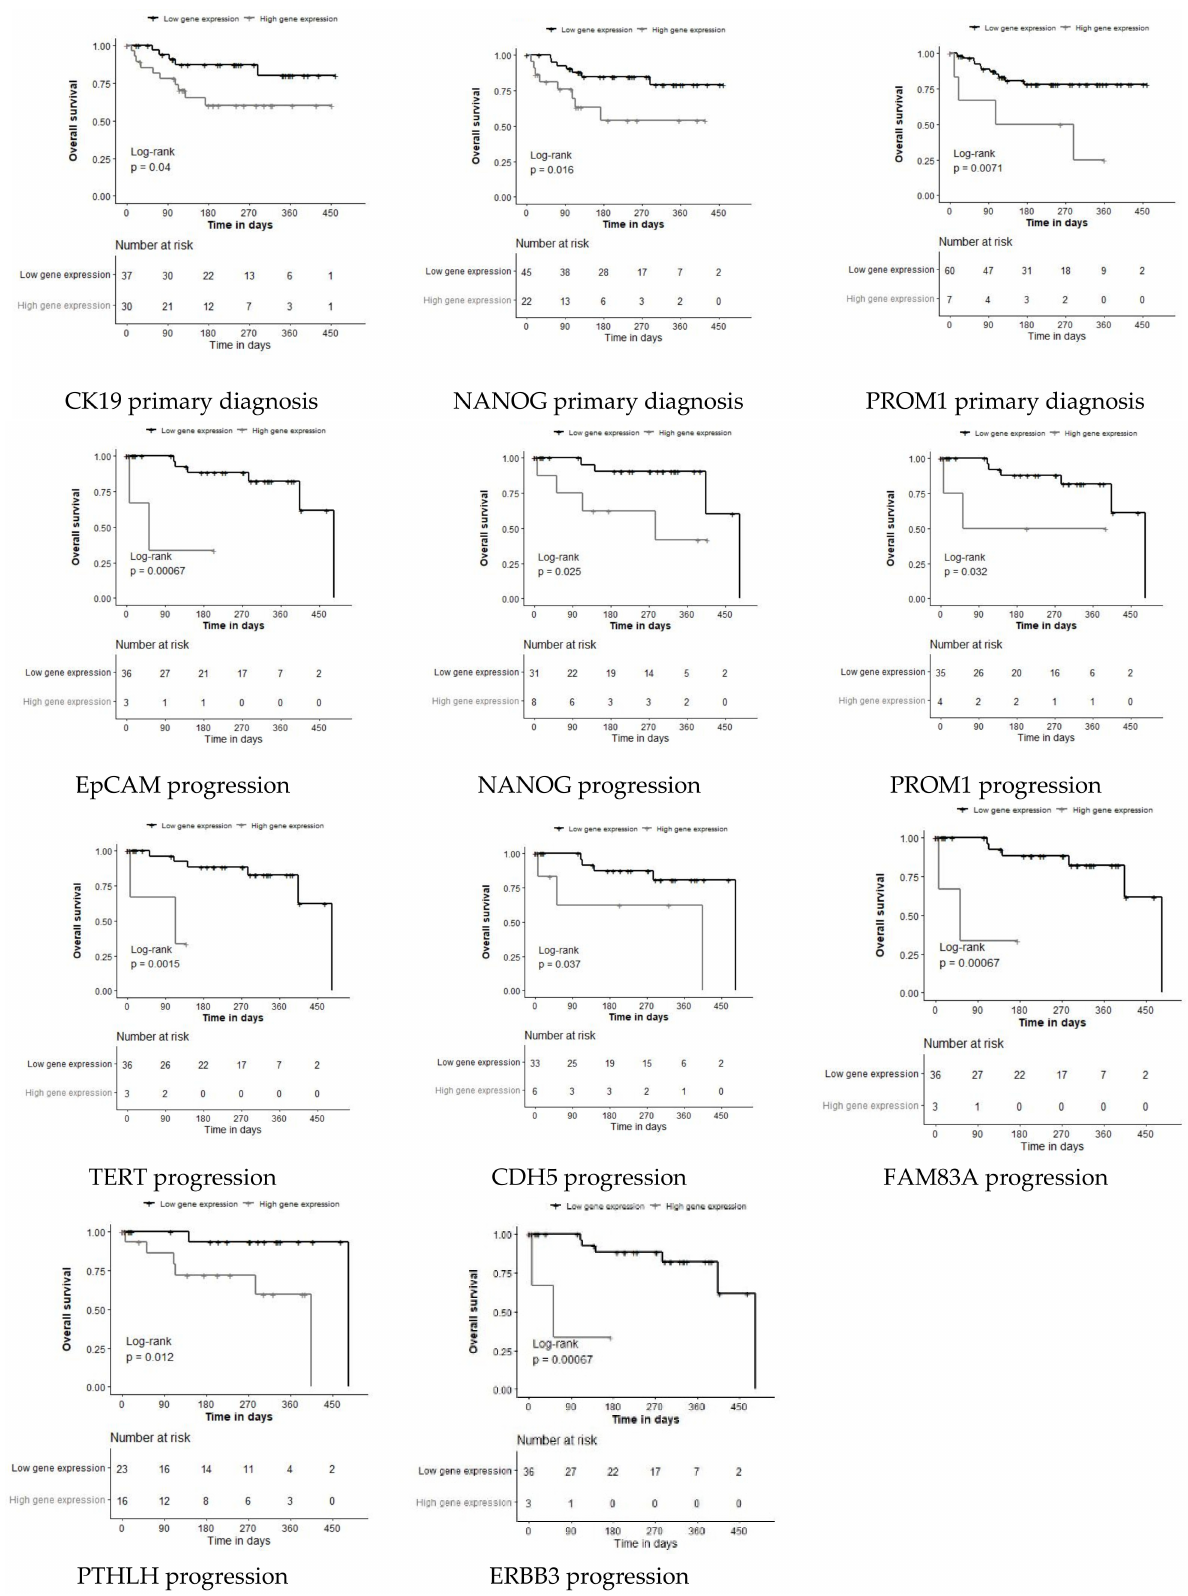
Figure 4. Overall survival plots of patients with univariate significant gene expression levels stratified by the prognostic threshold determined using the R-package Survminer, providing a value of a cut point that corresponds to the most significant relation with overall survival at primary diagnosis and at disease progression. p -values correspond to log-rank